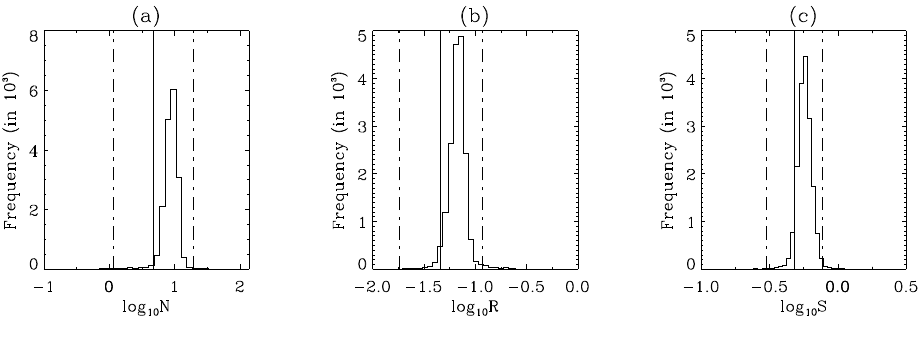
Fig. 8. Histograms of number density (a) , median radius (b) , distribution width (c) as retrieved from SAGE II measurements of aerosol extinction in December 1999. The vertical lines indicate the a priori mean state (solid), and the a priori mean state plus or minus one standard deviation (dash-dot).